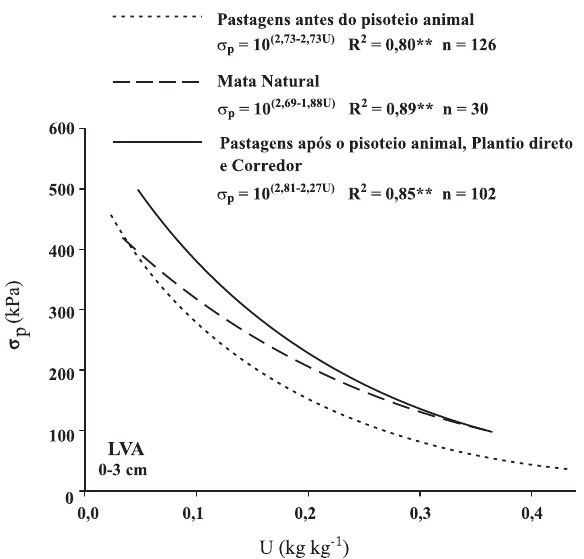
figura 3. Modelos de capacidade de suporte de carga dos diferentes usos e